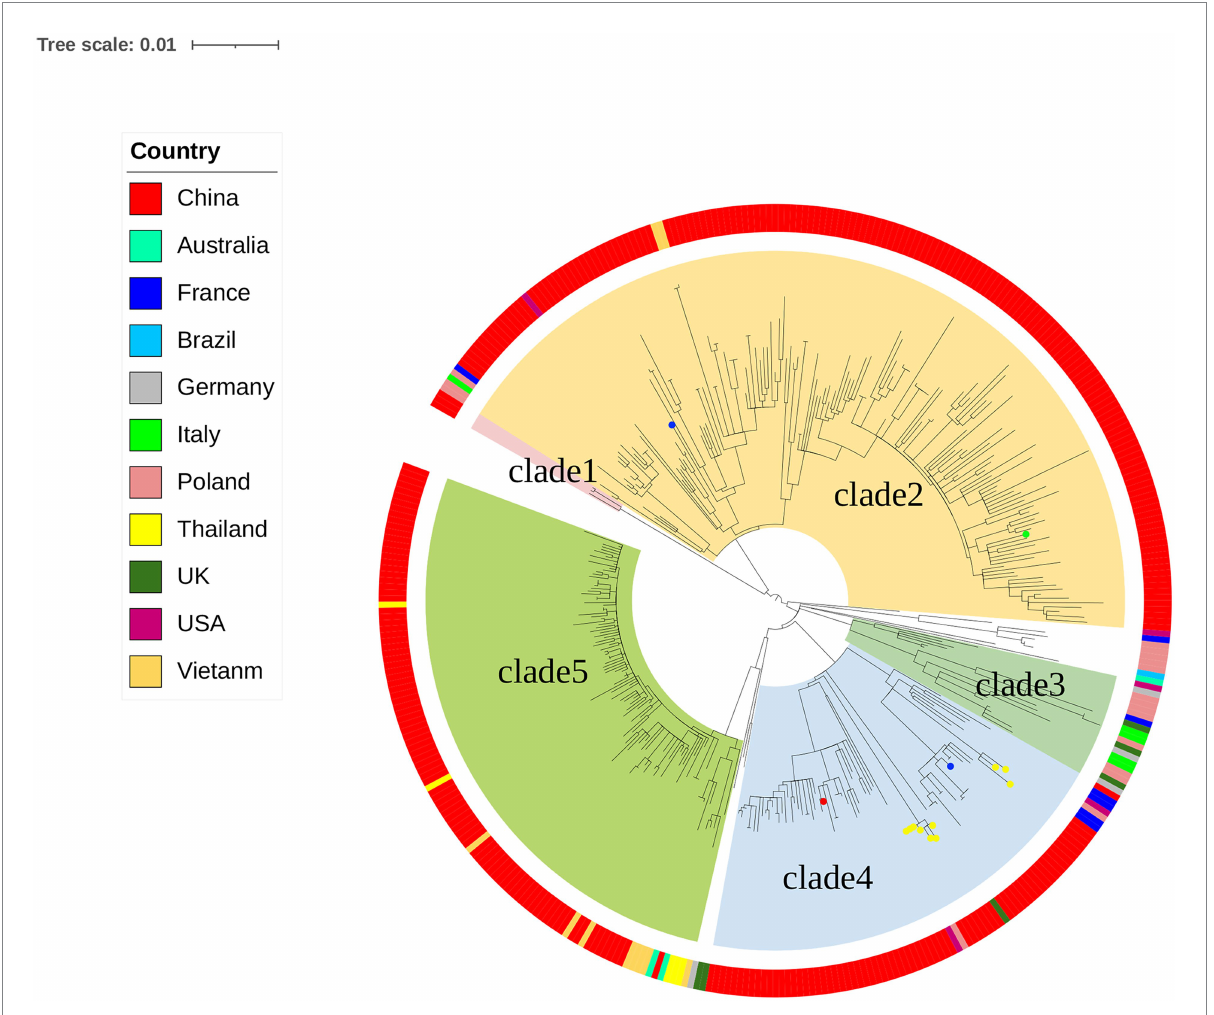
FIGURE 1 Maximum likelihood phylogenetic tree of 390 Salmonella strains. The background colors of the phylogenetic branches indicate the different evolutionary branches. Outer circles indicate different countries and the circles at the ends of the branches indicate other cities in China (blue, Shandong, China; green, Yangzhou, China; yellow, Taiwan, China; red, Tibet,